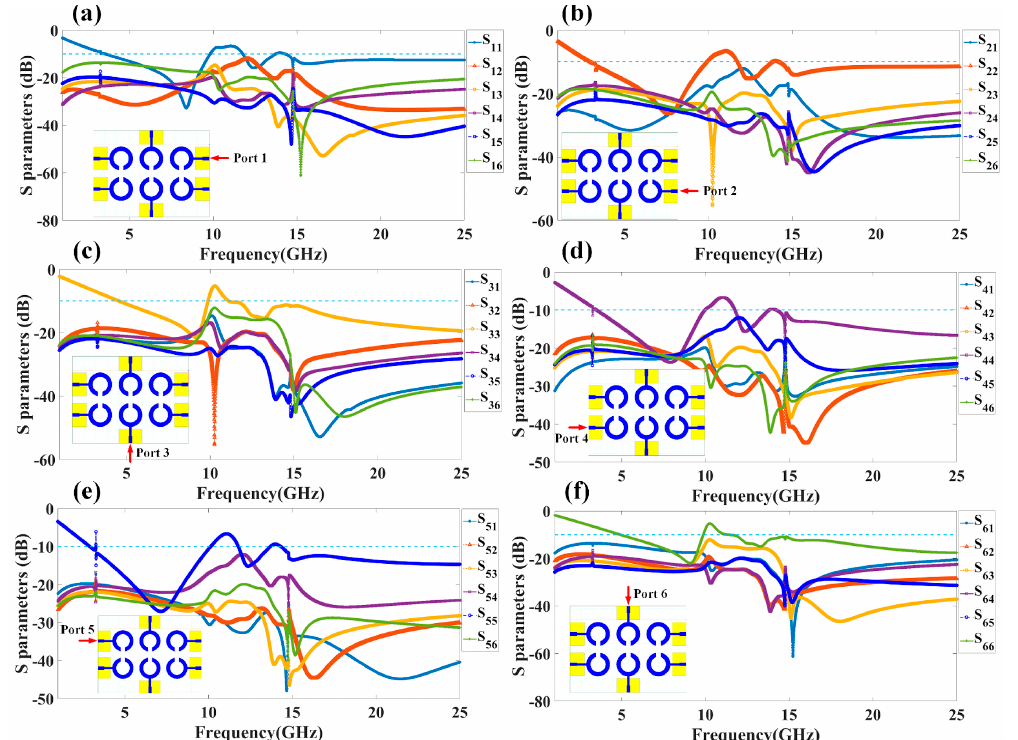
Figure 3. Numerically calculated reflectance coefficients for the different proposed MIMO antenna Design 5. The results are presented in terms of the S parameters, such as S ij, where i, j = 1, 2, 3, 4, 5, and 6 for indication of specific reflection coefficient at port. The S parameters are calculated by considering excited at ( a ) Port 1, ( b ) Port 2, ( c ) Port 3, ( d ) Port 4, ( e ) Port 5, and ( f ) Port 6. Dotted line is put for the reference to identify the reflectance < − 10